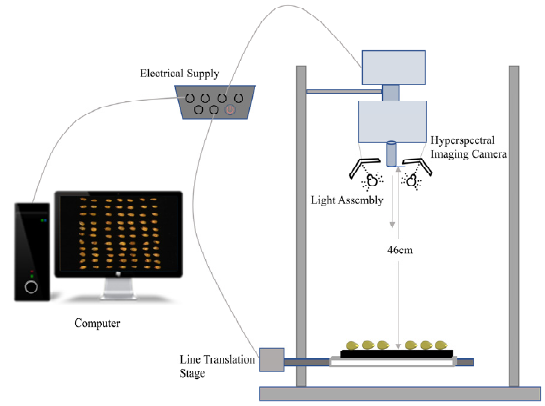
Figure 1. Hyperspectral imaging system.